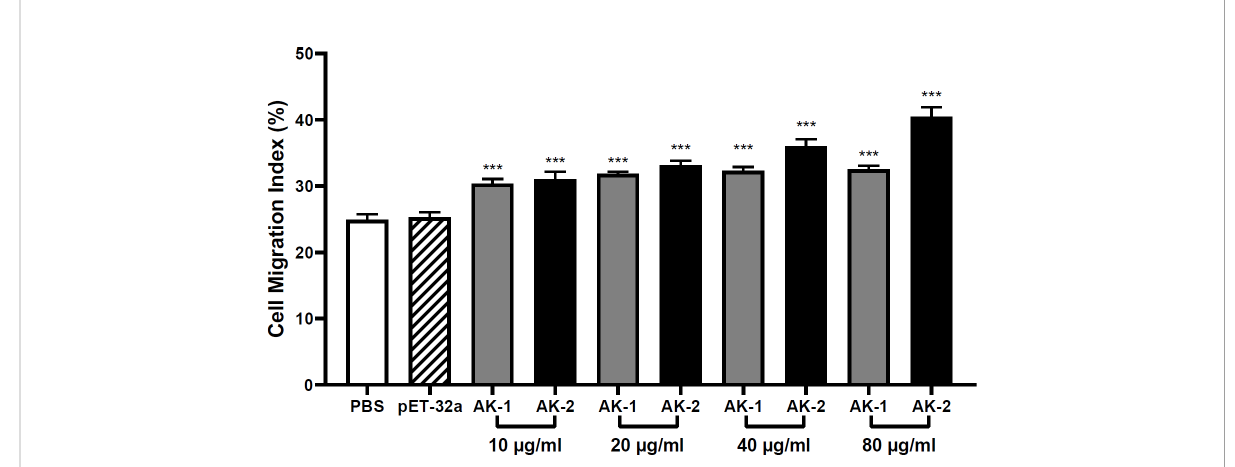
FIGURE 9 The effects of the rSsAKs on PBMC migration. The PBMC migration was counted using a Neubauer counting chamber. The migration ratio = total number of cells in the lower chamber after migration/total number of cells before migration. Data are the mean ± SD of three replicates per group as compared to the PBS group. *** P <